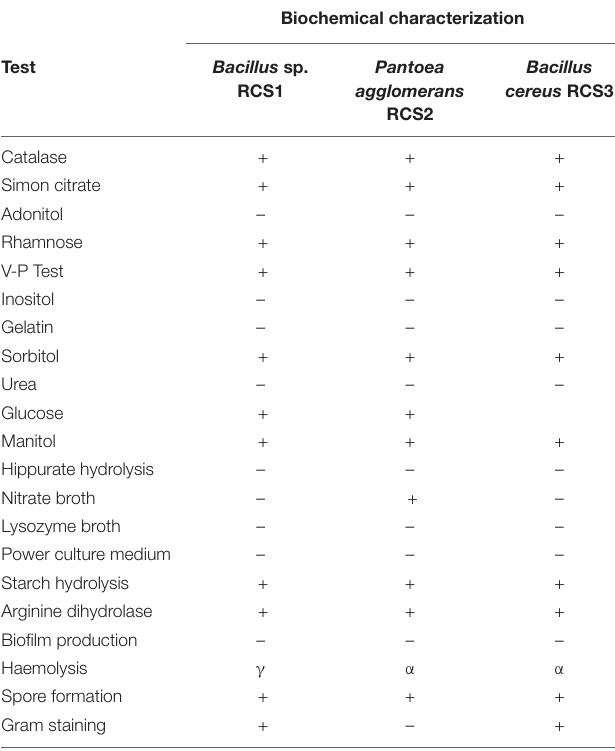
TABLE 1 | Biochemical characterization of isolated bacterial strains.